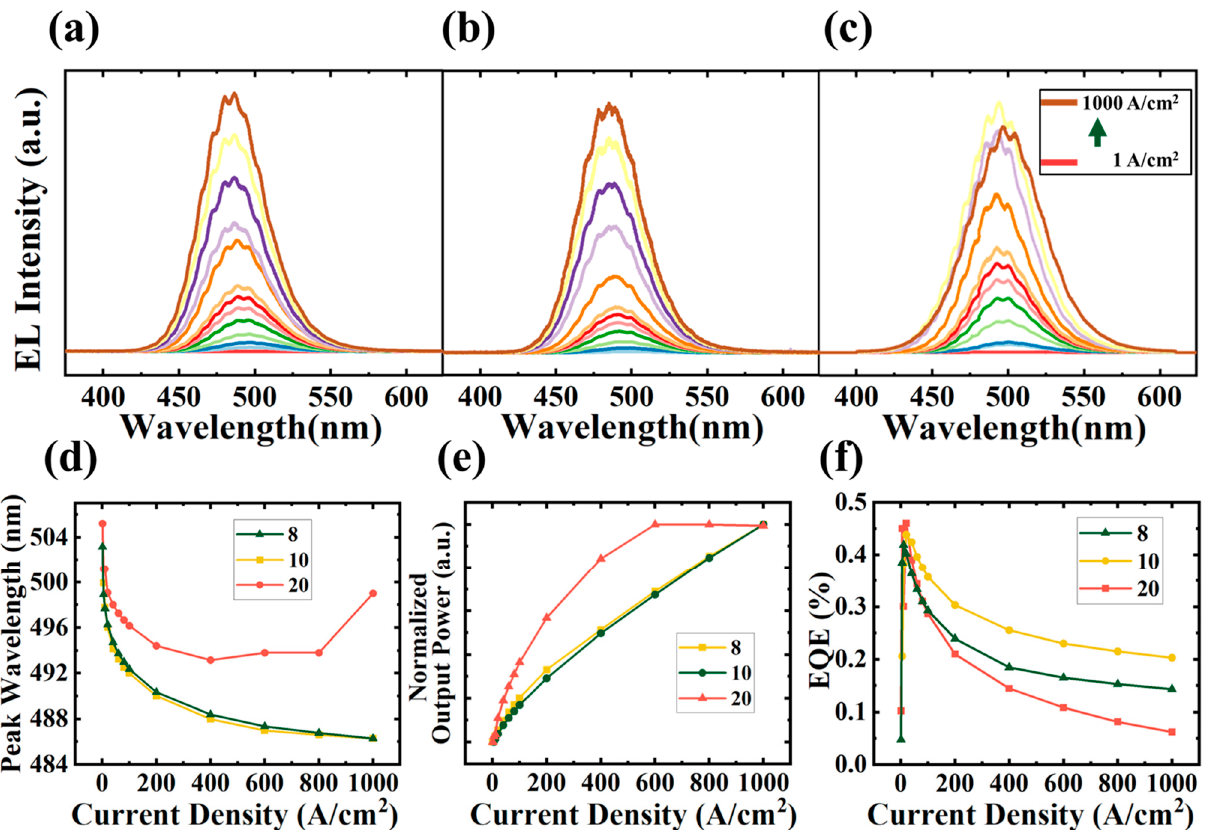
Figure 5. EL spectra of ( a ) 8 µ m, ( b ) 10 µ m and ( c ) 20 µ m InGaN QD micro-LEDs array under injection current densities from 1 A/cm 2 to 1000 A/cm 2 ; the variation of ( d ) EL peak wavelength, ( e ) LOP, and ( f ) EQE with injection current.